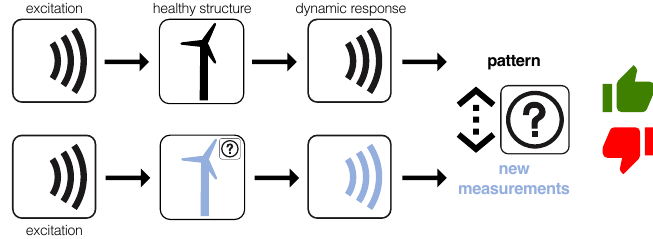
Figure 1. Vibration-based structural health monitoring. The structure is excited by a prescribed and known signal.